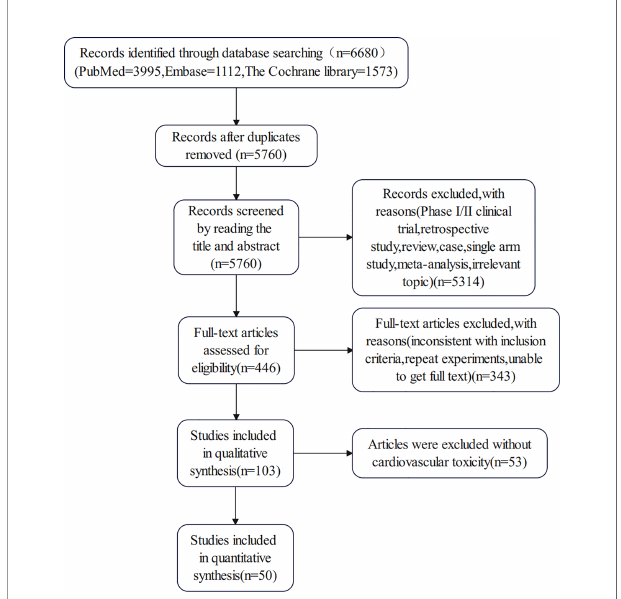
FIGURE 1 | The fl ow diagram describing systematic search for